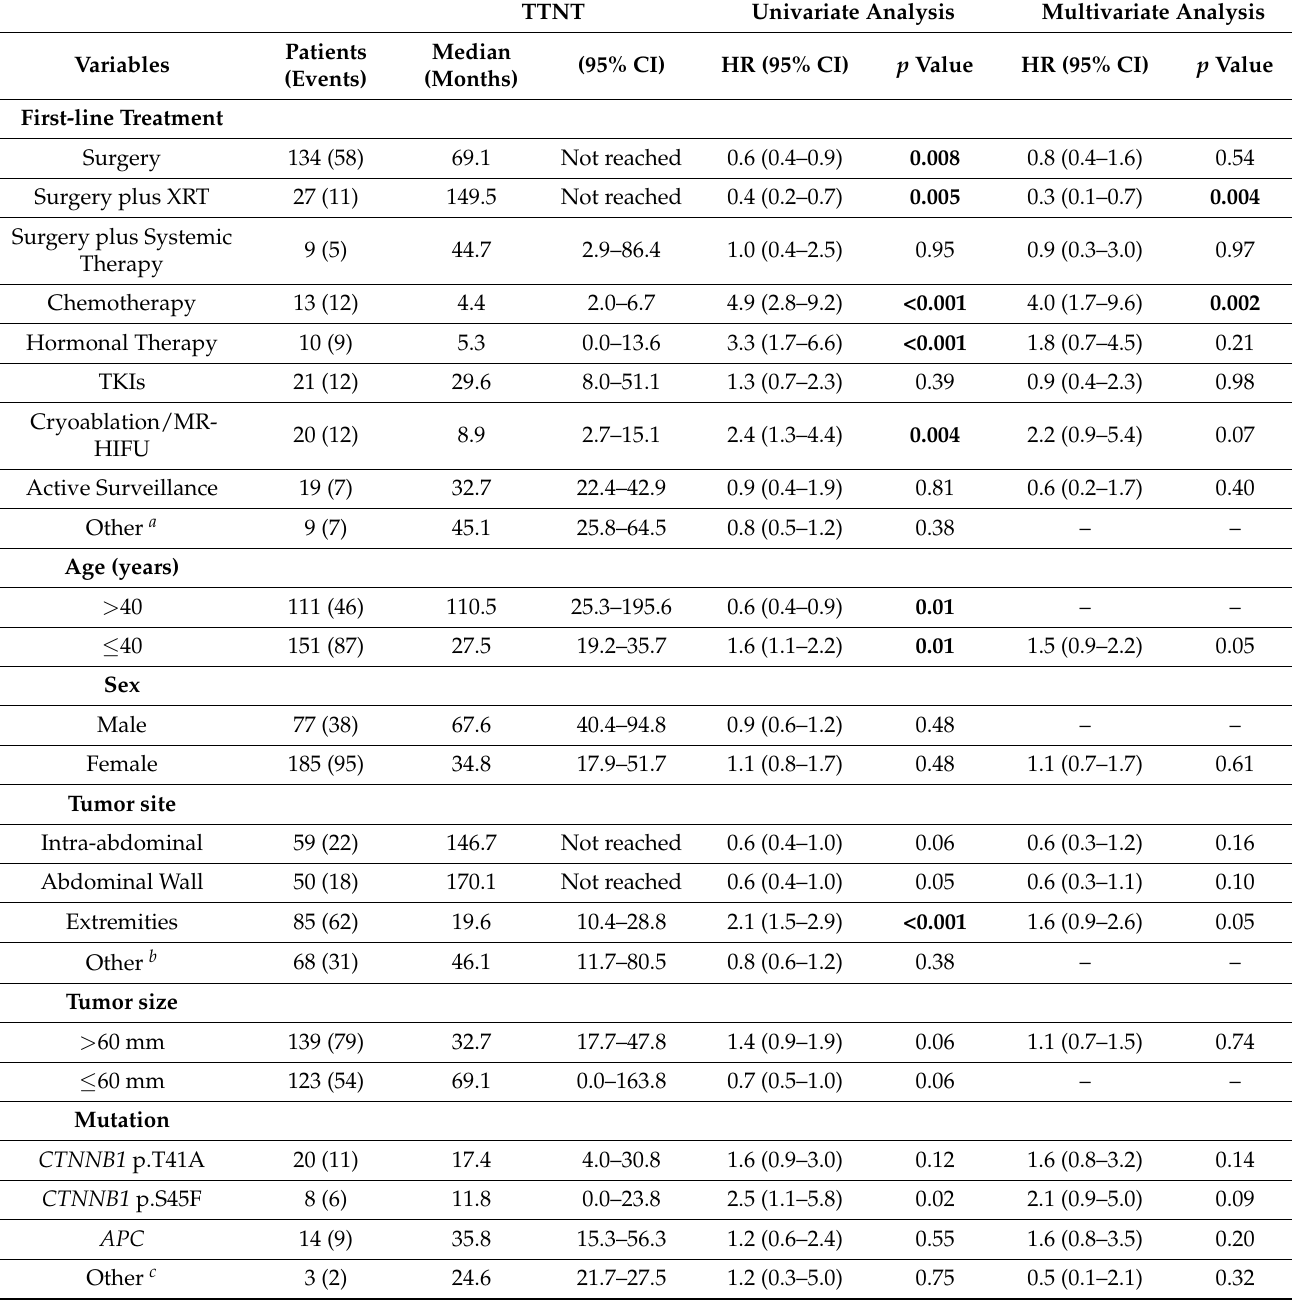
Table 3. Time to next treatment after first-line